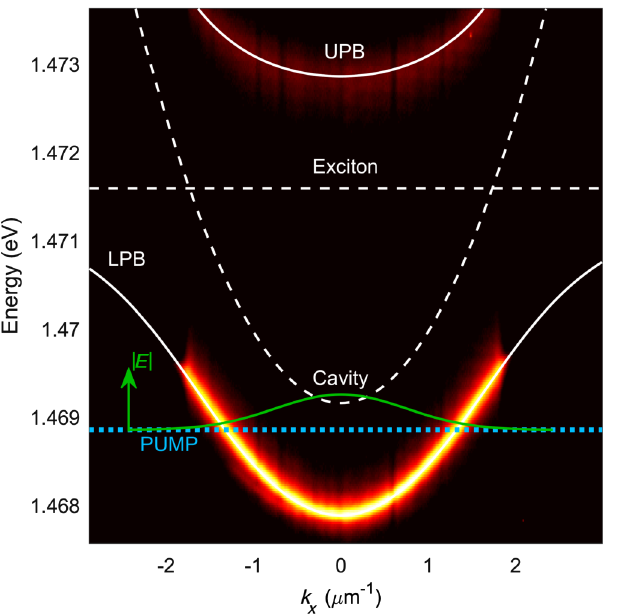
FIG. 1. Pumping scheme. Experimentally measured angle- resolved photoluminescence spectrum with fitted curves (white lines) showing both the uncoupled (dashed) and coupled (solid) modes of the system. The blue dotted line shows the energy of the pump laser and the green solid line shows its Gaussian intensity profile and accompanying axis. j E j is the electric field amplitude. UPB: upper polariton branch.